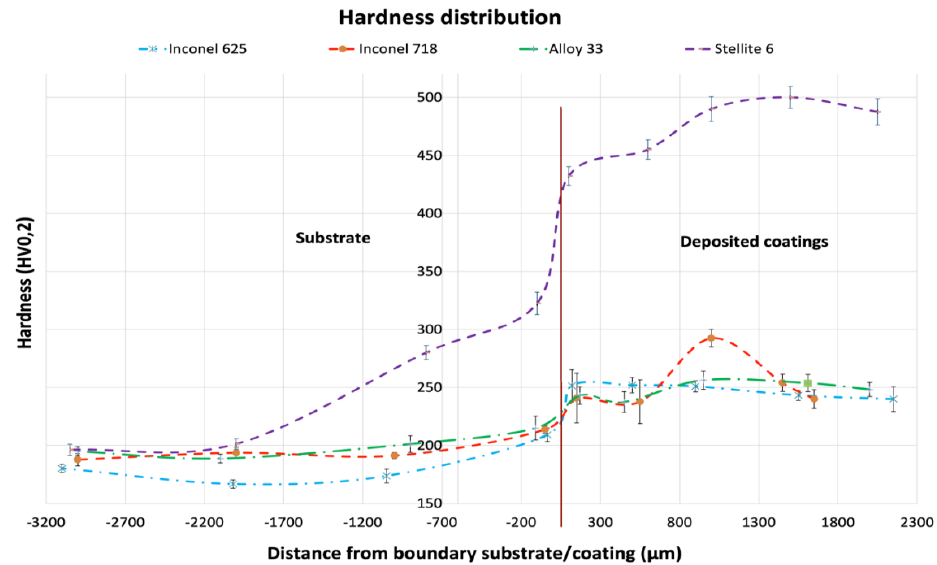
Figure 10. Distribution of microhardness in a cross-section of substrate material and the arc sprayed Fe-Al coating, before and after annealing in temperature. Fe-Al coating, before and after annealing in